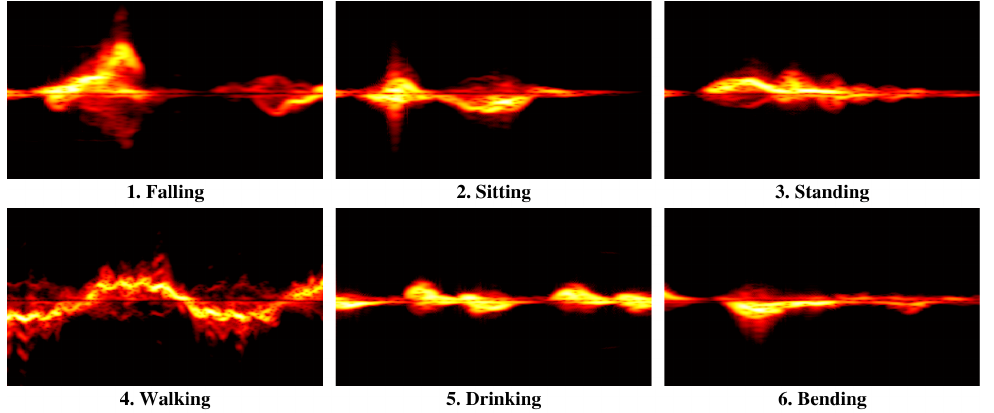
Figure 5. Samples of the acquired micro-Doppler signatures of six different